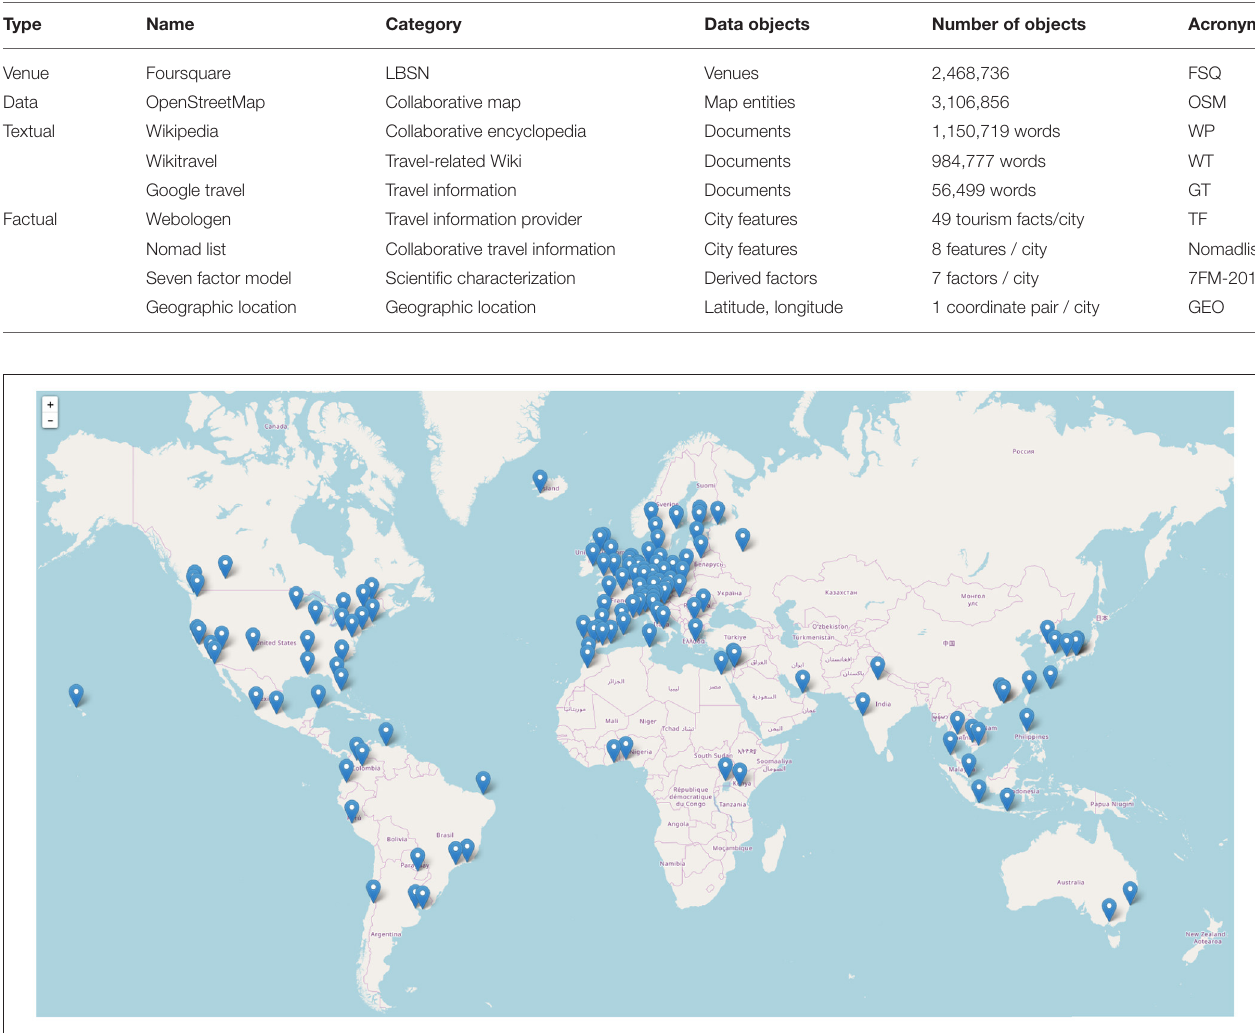
TABLE 1 | Overview of the data sources for characterizing cities.